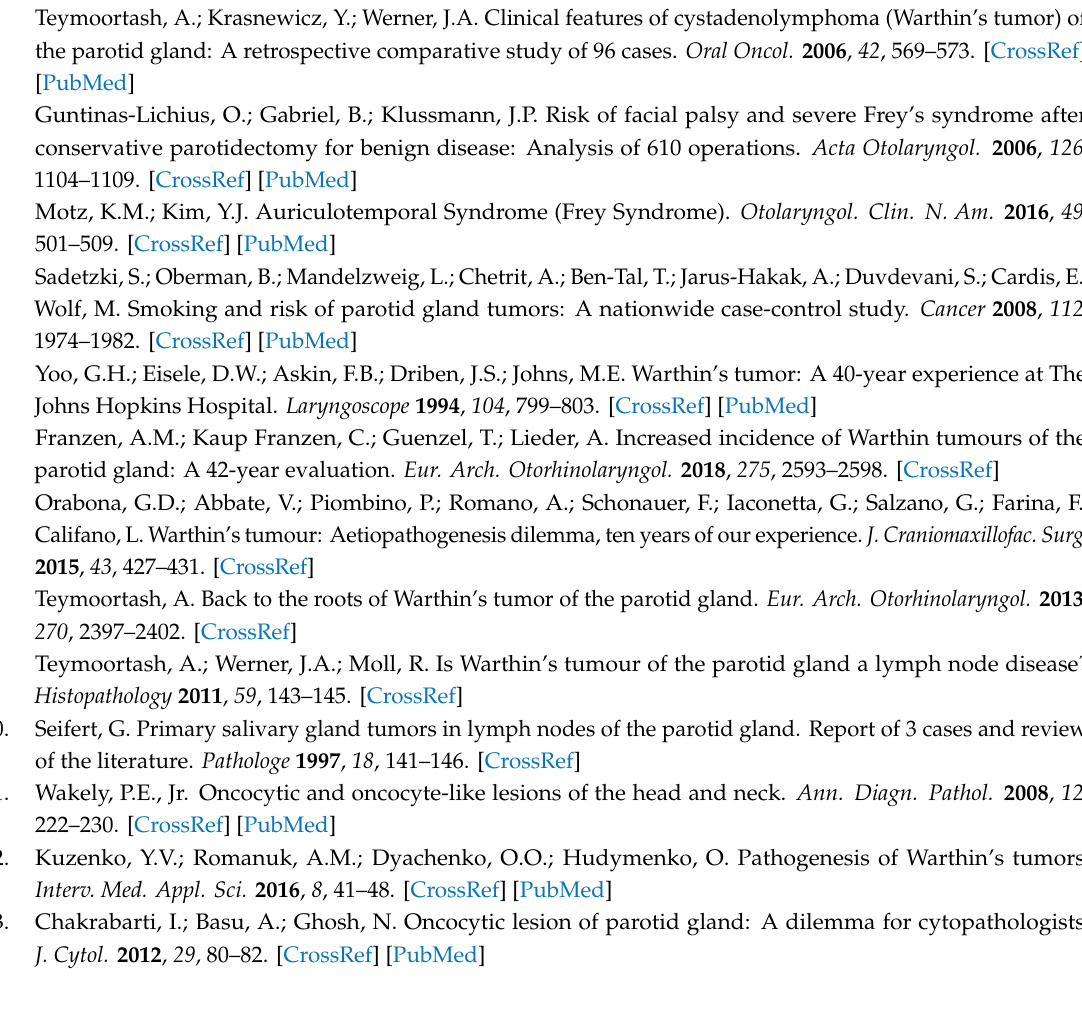
Figure S1: Single cell dissociation of WT tissue allows separating the lymphocytic (Gate 1) and oncocytic (Gate 2) compartments, using FACS. Subsequent flow cytometry (A) and Western blot (B) analysis of sorted Gate 1 and Gate 2 cells, using CD3- and CK-specific antibodies validates the successful separation of both